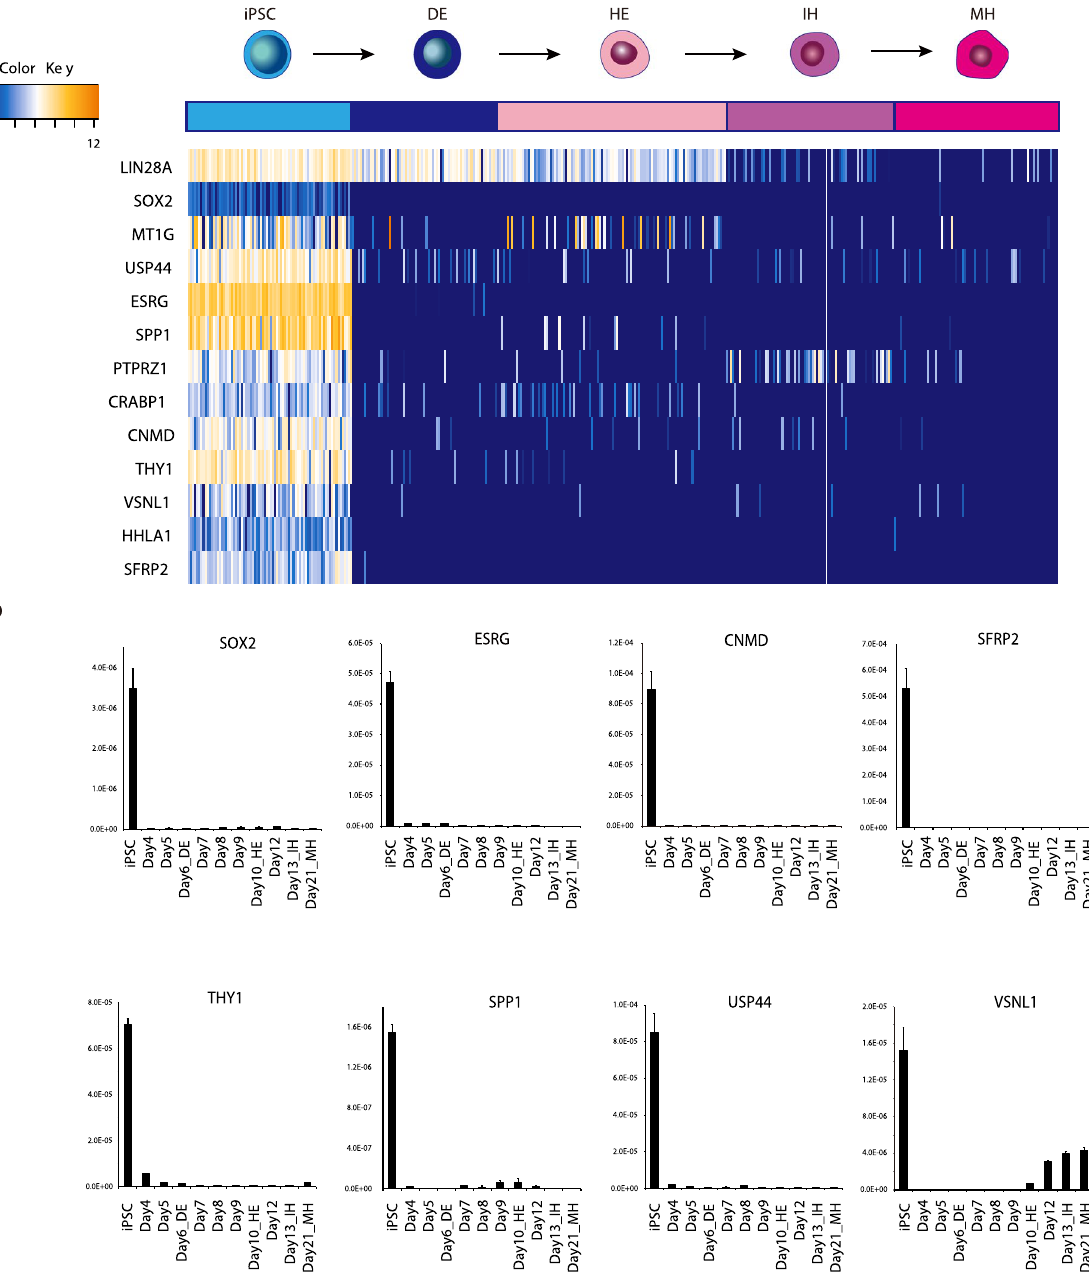
Figure 2. Identification of candidate genes for detecting undifferentiated iPSC during hepatic differentiation. ( a ) Single-cell RNA sequence analysis identified novel candidate genes. Upper illustration and color column represents differentiation lineages from undifferentiated iPSC to mature hepatocyte (MH). DE: definitive endoderm, HE: hepatic endoderm, IH: immature hepatocyte. ( b ) qPCR analysis of marker gene candidates during hepatic differentiation. Down regulation of gene expressions during hepatic differentiation. The relative expression levels were normalized by the amount of 18S rRNA in each